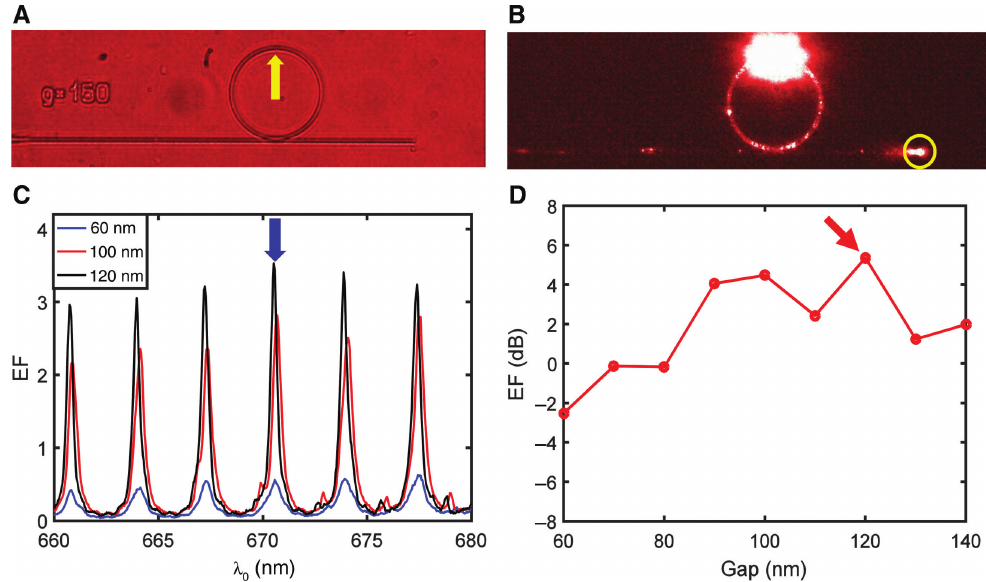
Figure 8: (A) Optical microscopy image of a resonator decorated with a colloidal QD aggregate deposited at the location shown by the arrow. (B) Fluorescent image showing the local activation of the resonator, and the scattering spot at the output waveguide end. (C) Enhancement factor spectra (reference taken from bare waveguide with no resonator) obtained for different separation gaps. Typical quality factor of the resonance around 2000–2500. (D) For the resonance close to 670 nm, enhancement factor of the output waveguide intensity spot relative to reference bare waveguides for increasing separation